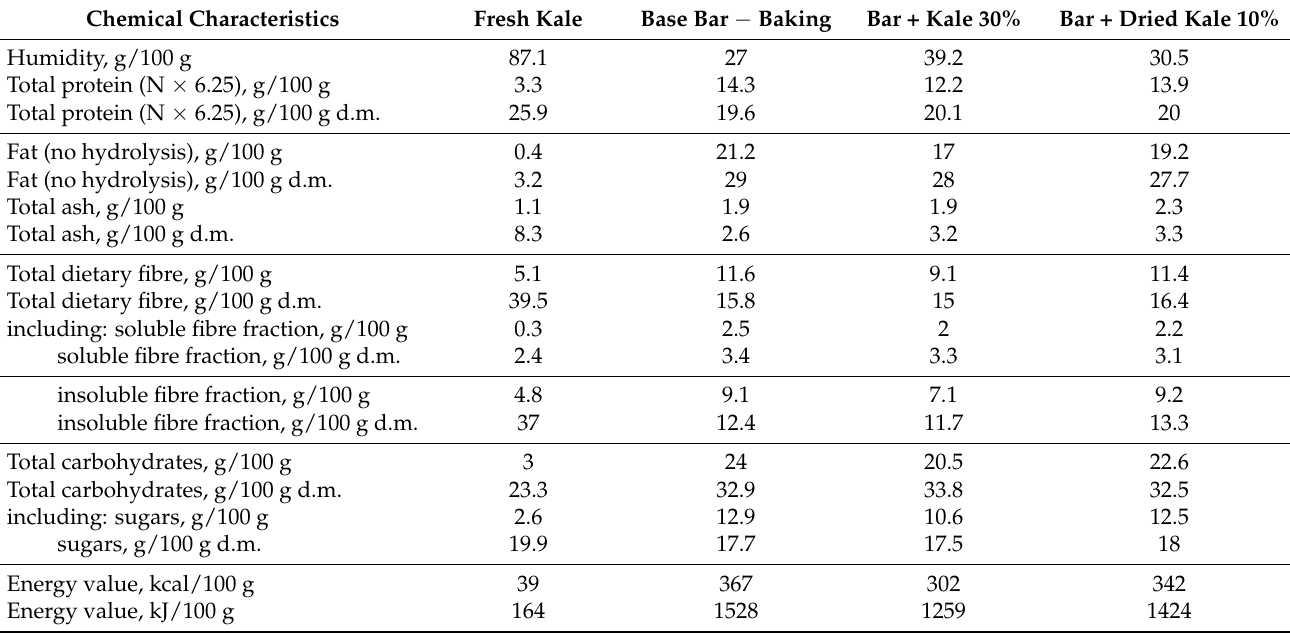
Table 1. Chemical characteristics of kale and multigrain bars with the addition of fresh and dried kale (microwave-blanched). Chemical